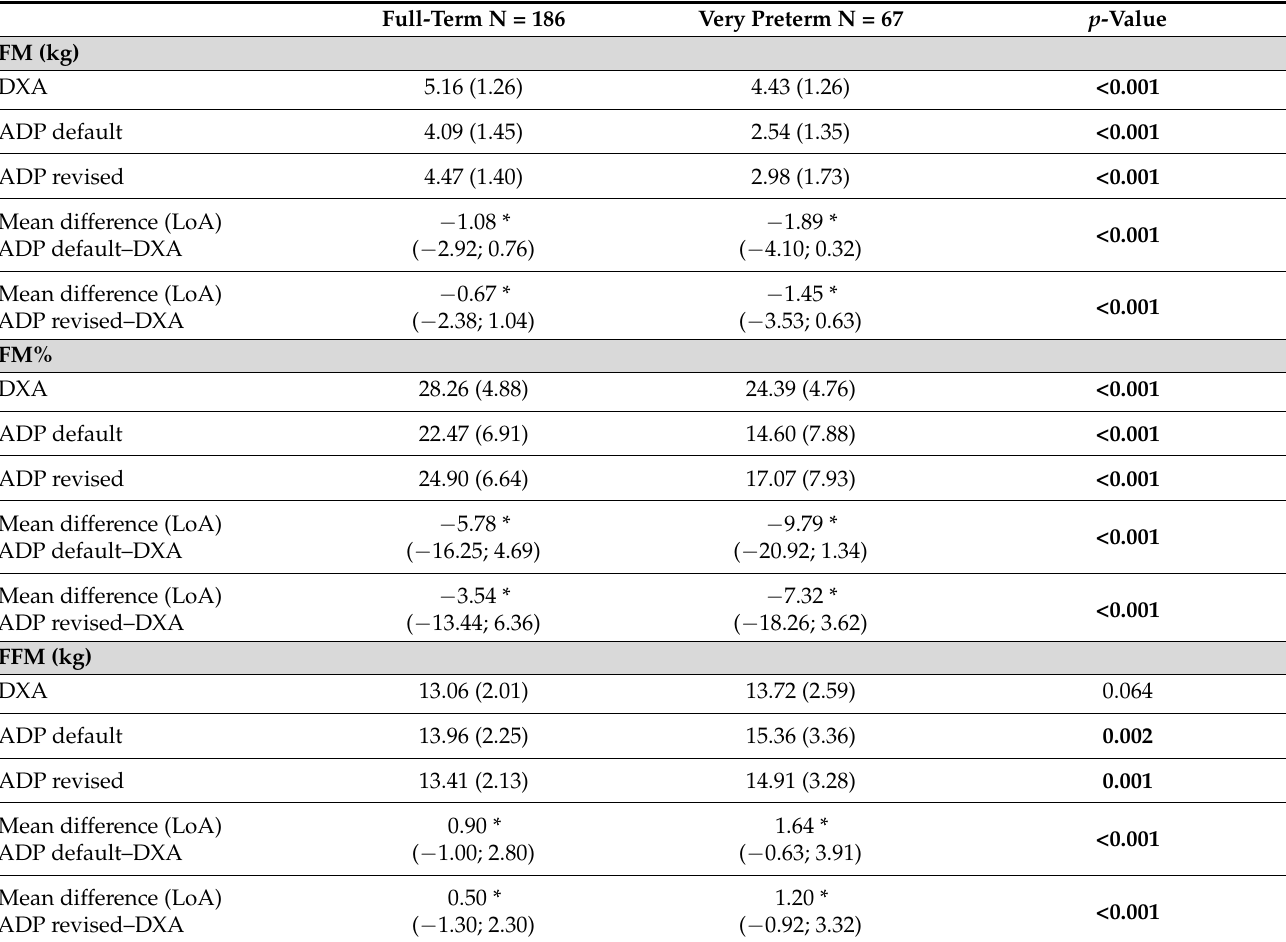
Table 2. Body composition parameters assessed by ADP and